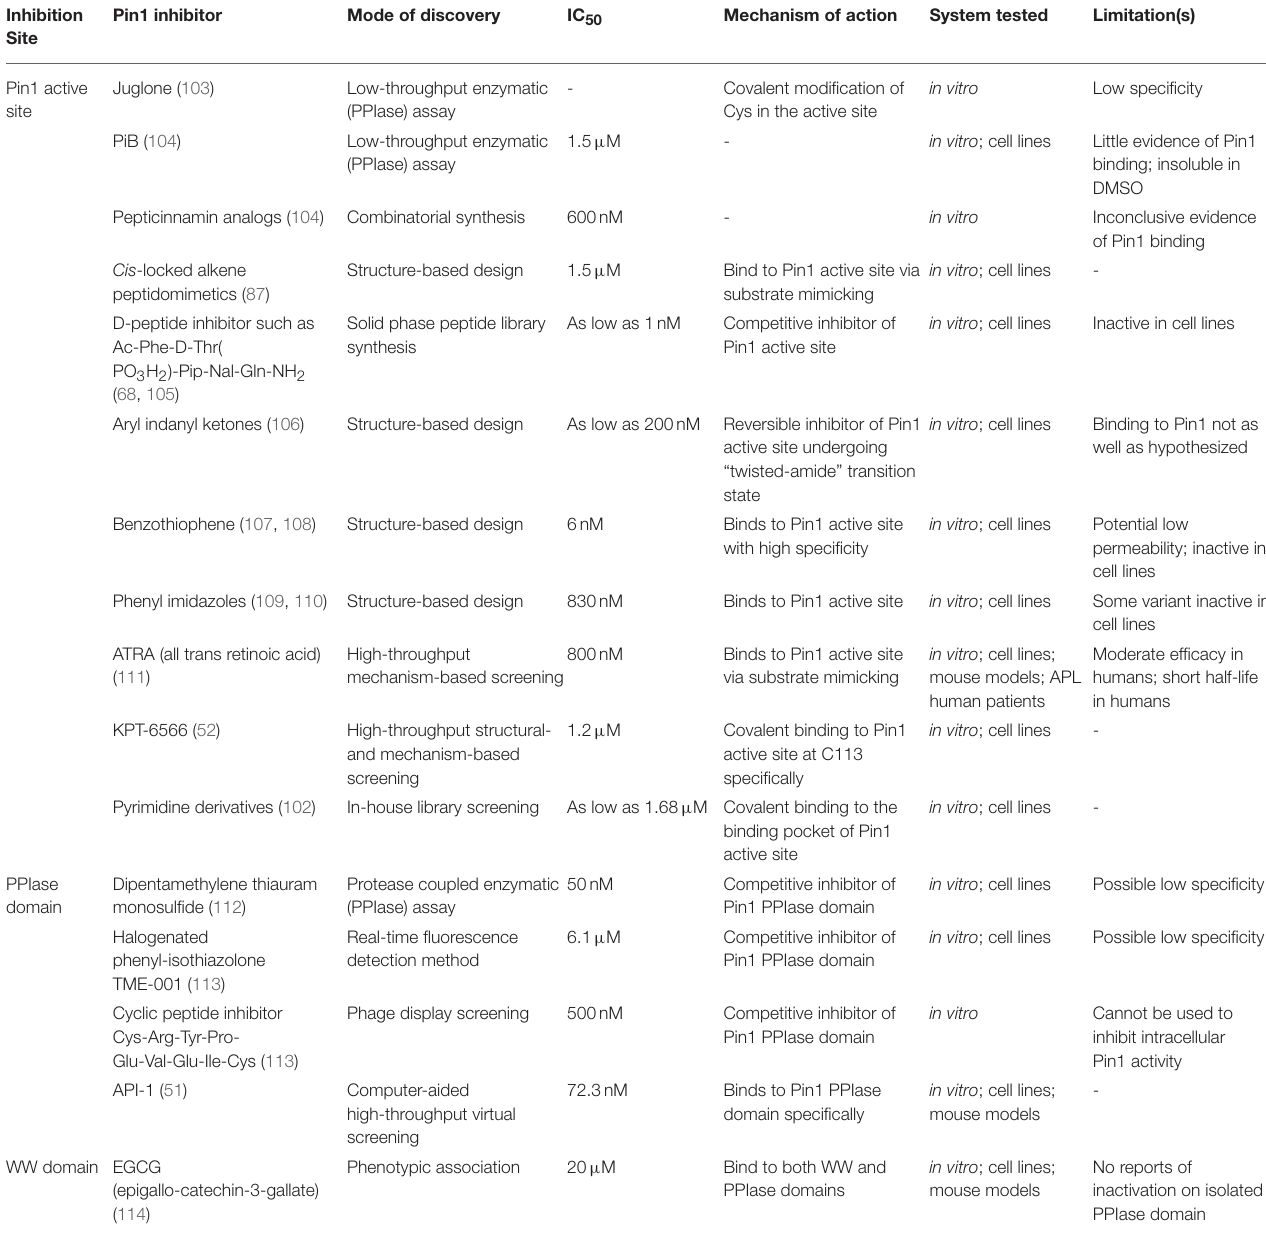
TABLE 1 | Selected known Pin1 inhibitors shown to block Pin1 function by targeting various part of Pin1 protein [adapted from Zhou and Lu (49)]. Inhibition